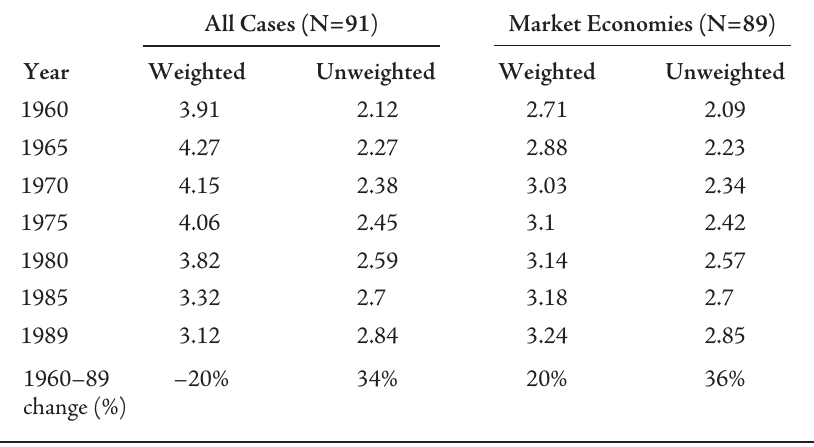
Table 3 – World Bank World Income Inequality